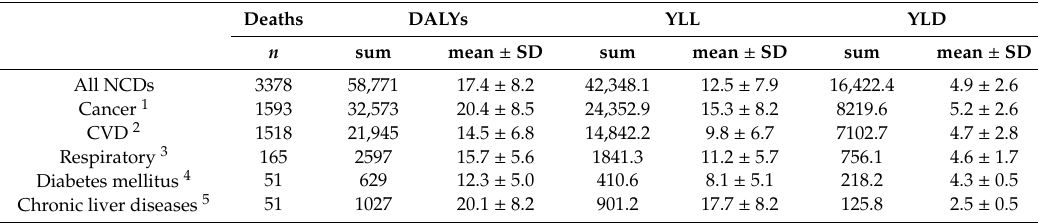
Table 2. The number of deaths, disability-adjusted life years, years of life lost, and years lost due to disability attributable to noncommunicable diseases in the NRP–MONICA cohort.